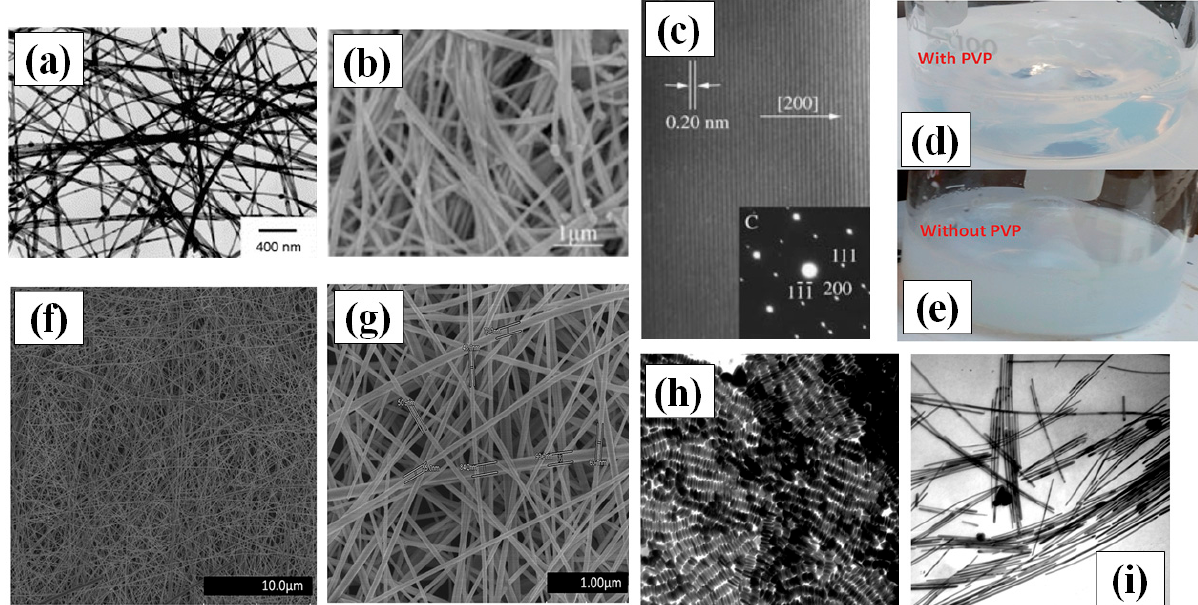
Figure 4. ( a ) TEM images synthesized AgNWs using 1,3-bis(cetyldimethylammonium) propane dibromide (adapted from [73] with permission from Elsevier, 2006) ( b ) SEM image of the prepared AgNWs using glucose as reducing agents (adapted from [72] with permission from Chemistry-A European Journal, 2005). ( c ) A HRTEM image and single crystal SAED pattern of AgNWs ( d – e ) Digital camera images of solutions prepared for hydrothermal synthesis ( d ) with PVP in the form of hydrosol and ( e ) without PVP having precipitates in solution ( f , g ) The SEM images of uniform, ultralong and thin AgNWs prepared by the hydrothermal method at 160 °C for 22 h of reaction (adapted from [74] with permission from Royal Society of Chemistry, 2013) ( h ) TEM image of shape controlled silver nanorods (using pH~11); scale bar = 100 nm. ( i ) TEM image of AgNWs (using pH~11); scale bar = 100 nm (adapted from [65] with permission from Royal Society of Chemistry, 1996).